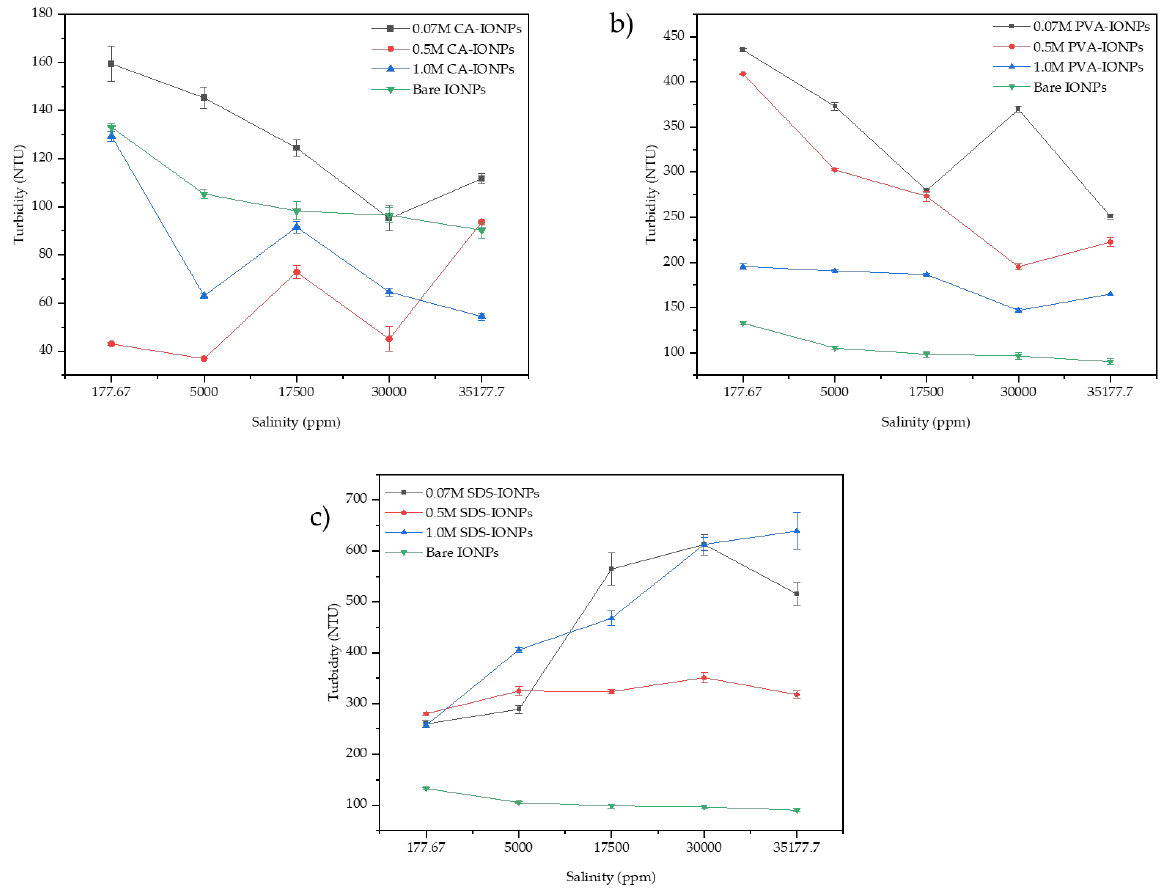
Figure 10. Turbidity values of CA-IONPs, PVA-IONPs and SDS-IONPs under various molar ratios and salinities.